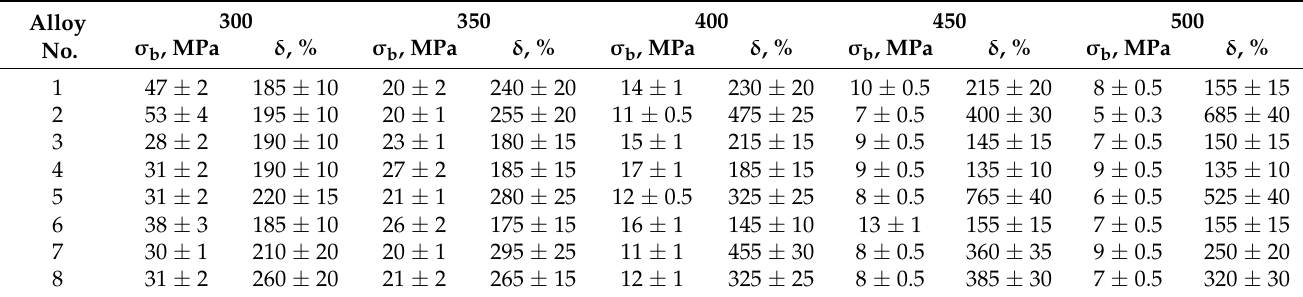
Table 3. Tensile tests of UFG alloys at elevated temperatures and a strain rate of 3.3 × 10 − 3 s − 1 .